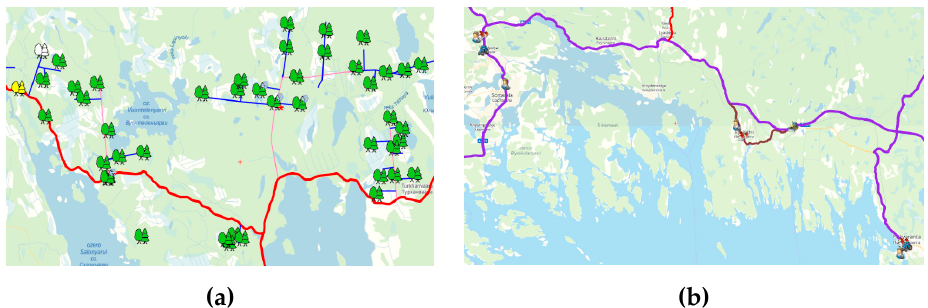
Figure 1. Interface of Opti-Wood software.